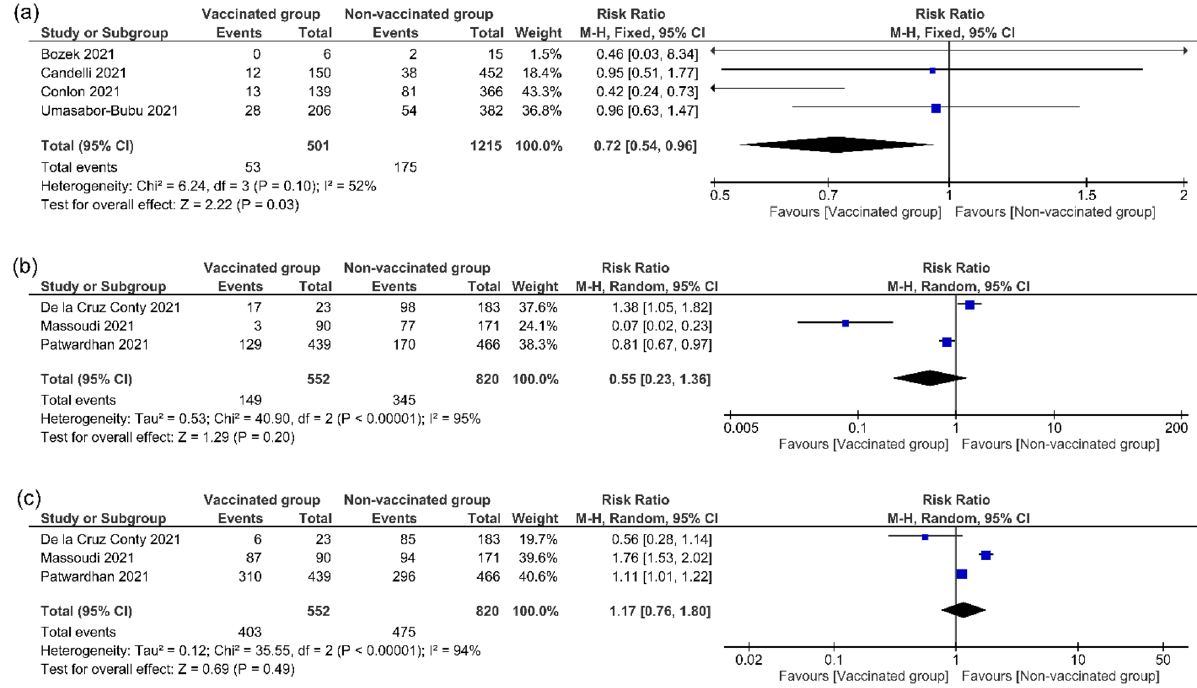
Figure 4. Mechanical ventilation and symptom’s appearance. This figure shows the forest plot of ( a ) mechanical ventilation, ( b ) symptomatic cases, ( c ) asymptomatic